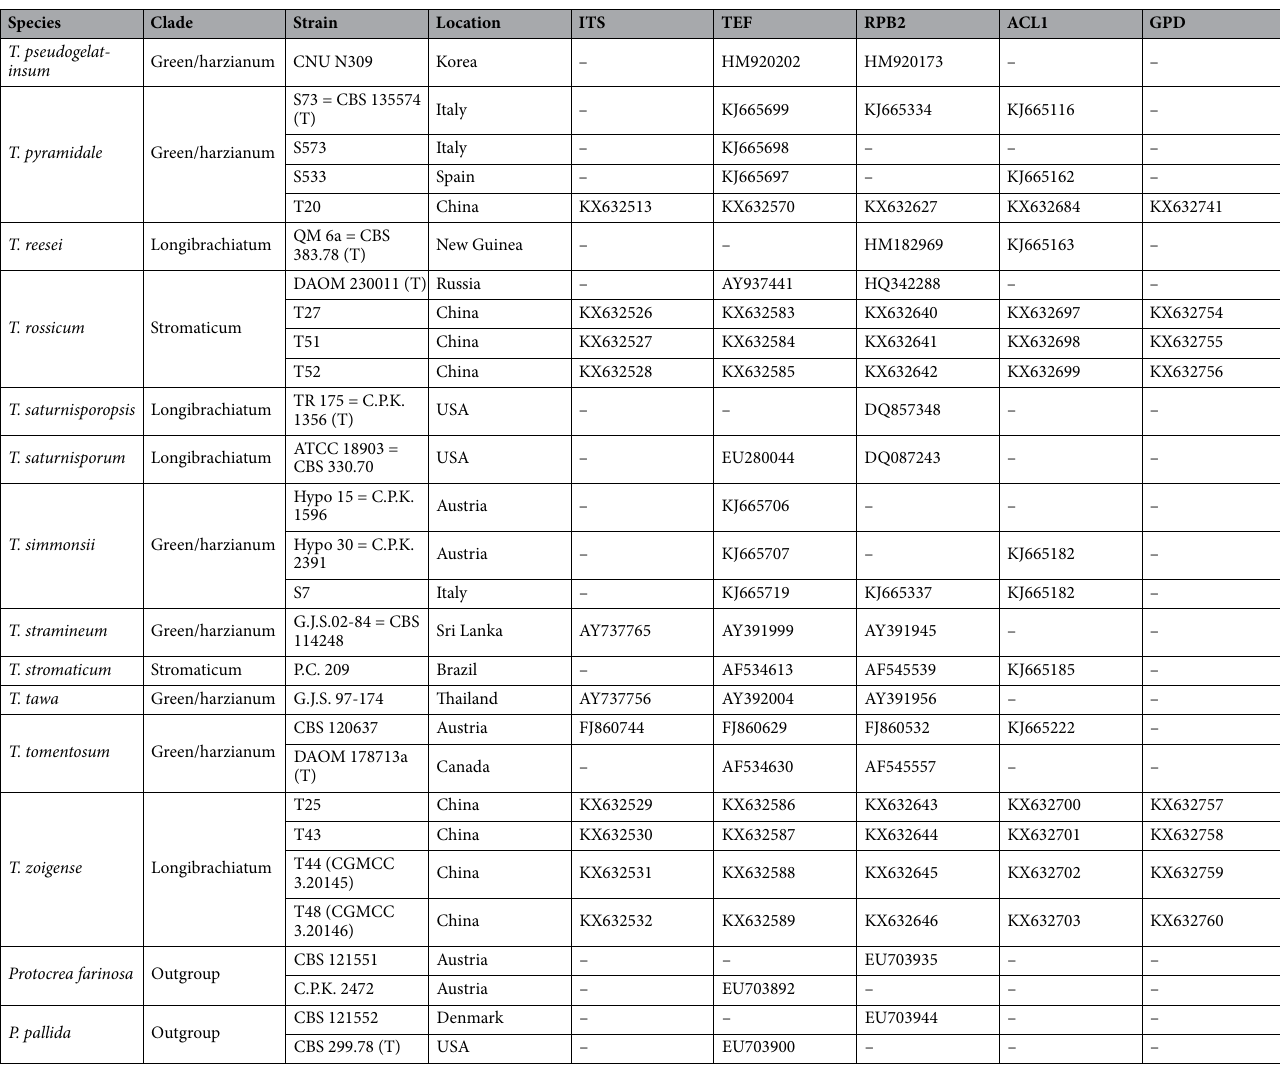
Table 2. Trichoderma strain included in the multi-gene sequence analysis, with details of clade, strain number, location, and GenBank accessions of the sequences